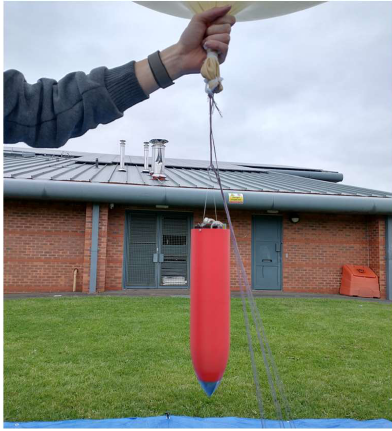
Figure 26. Capsule payload suspended beneath the balloon.